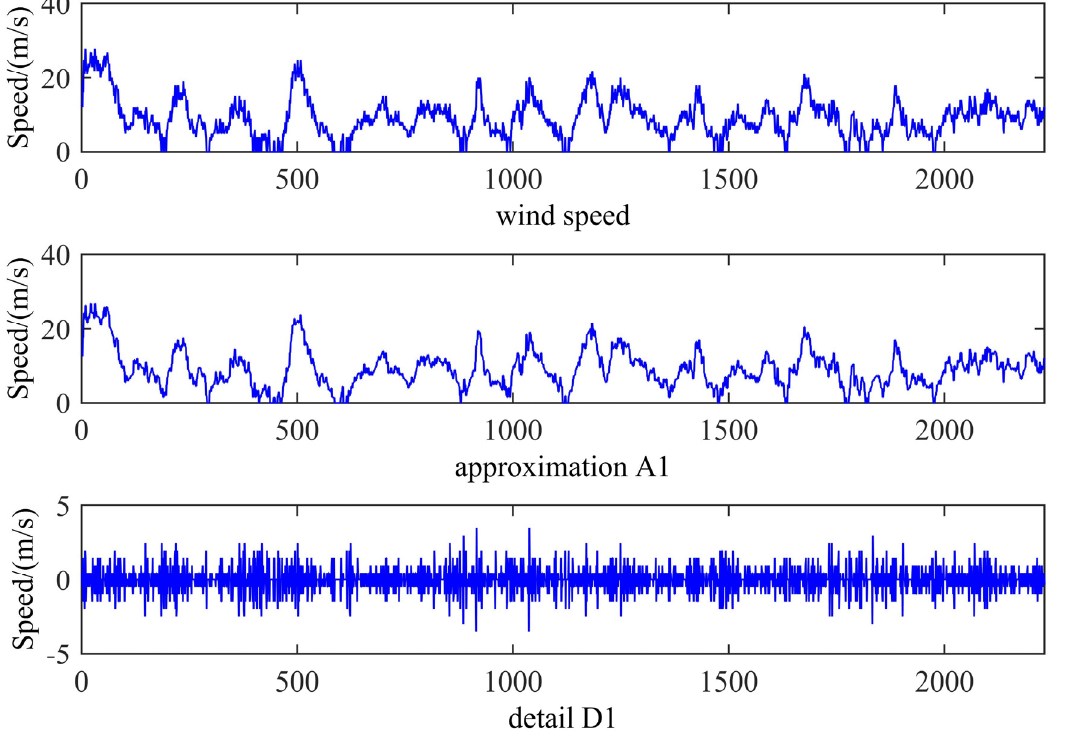
Figure 6. The decomposition of the wind speed during the period from 1 January to 31 January 2011 by